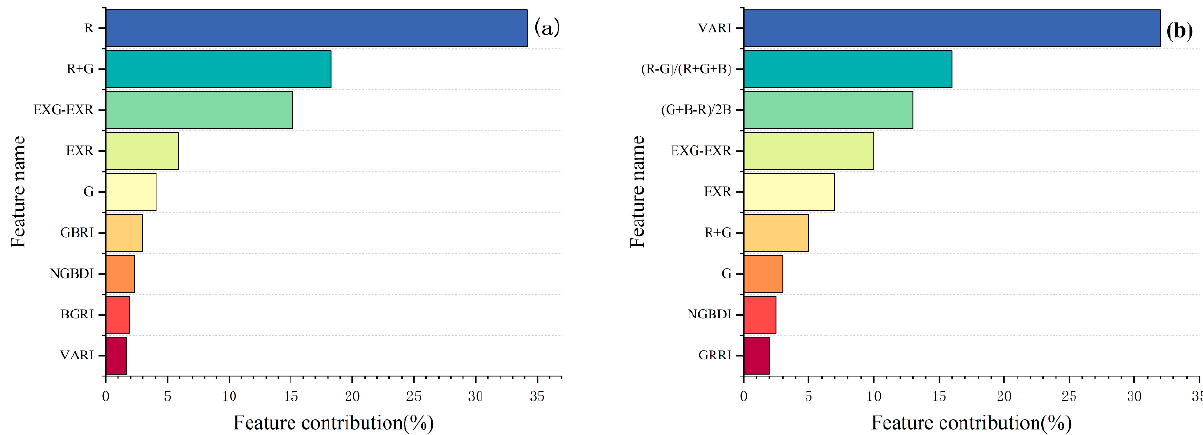
Figure 7. Importance ranking of Vis: ( a ) LCC-VIs; ( b ) FVC-VIs. Note: Only the top nine VIs in the importance ranking are shown here. Table 5. LCC and FVC estimation